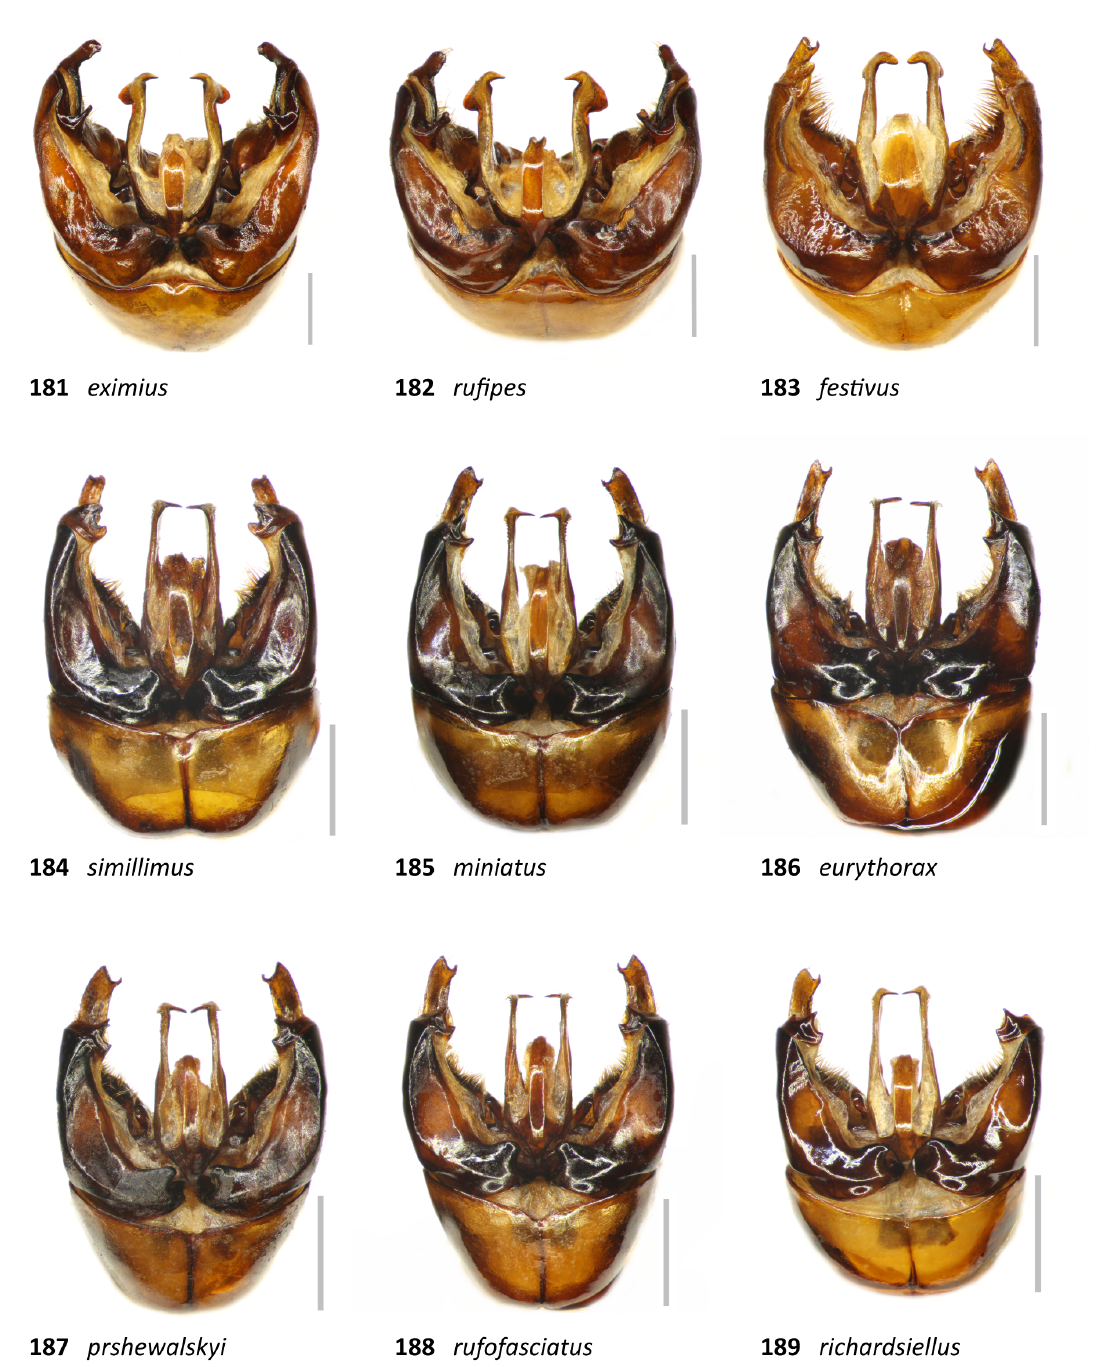
Figs 181‒189. Morphology of the male genitalia for species of the subgenus Melanobombus von Dalla Torre, 1880 from the dorsal aspect, anterior at the bottom of the image, posterior at the top. 181 . Bombus eximius Smith, 1852, China-Guangxi. 182 . B. rufipes Lepeletier, 1835,